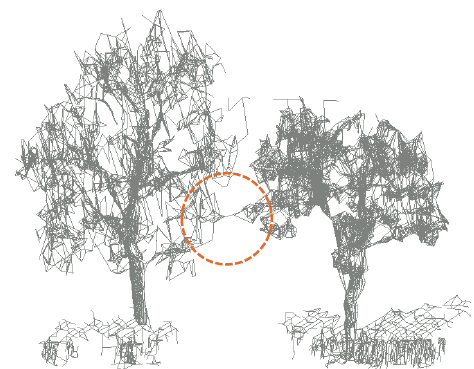
Figure 14 . An example of false negative by occlusion by a parking vehicle